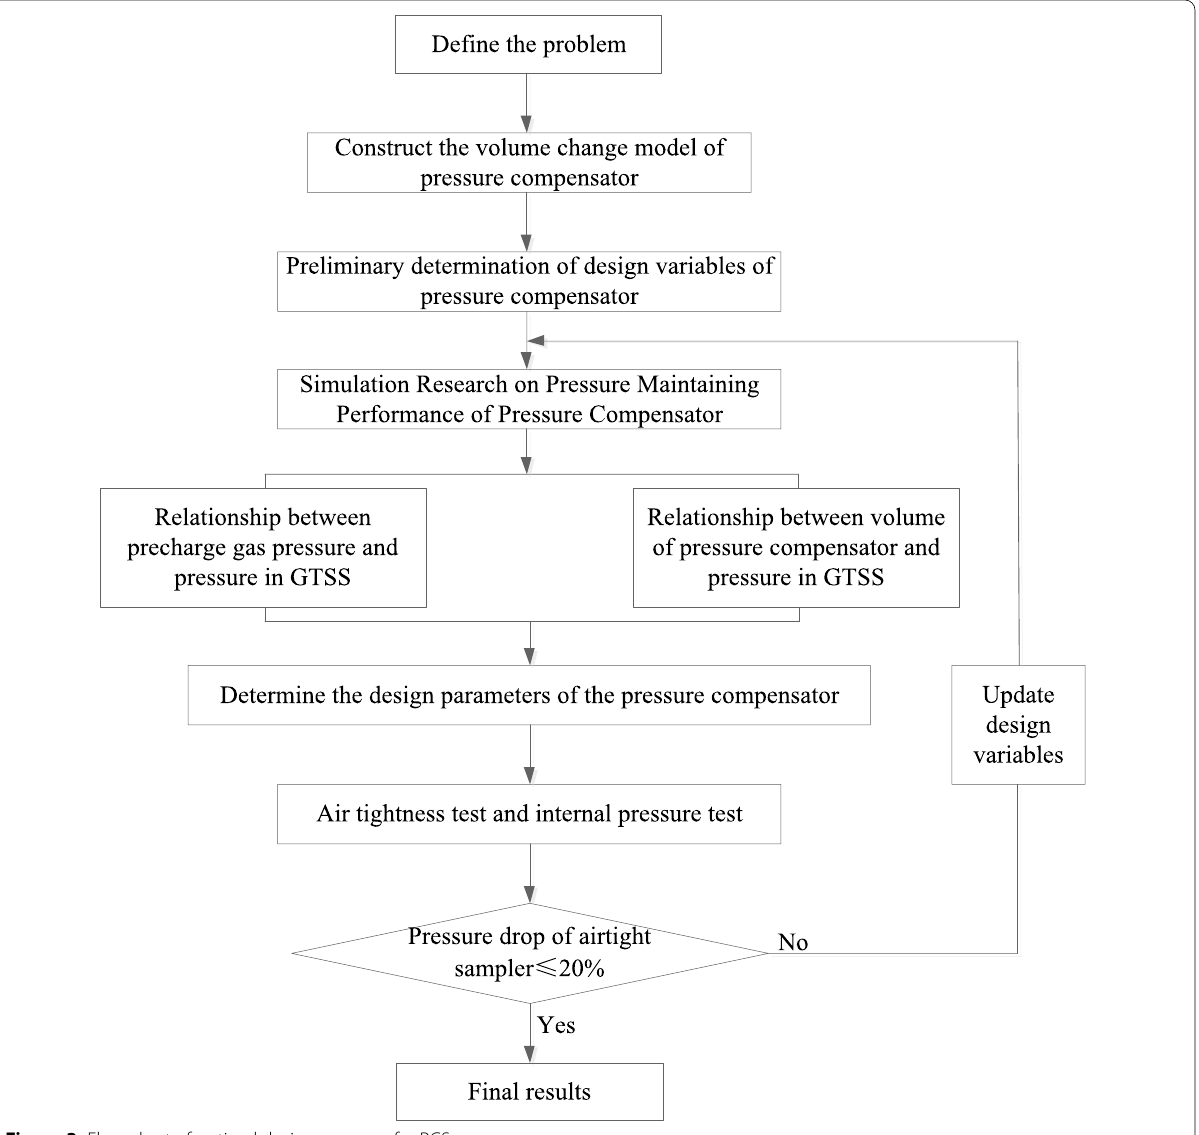
Figure 3 Flow chart of optimal design program for PCS